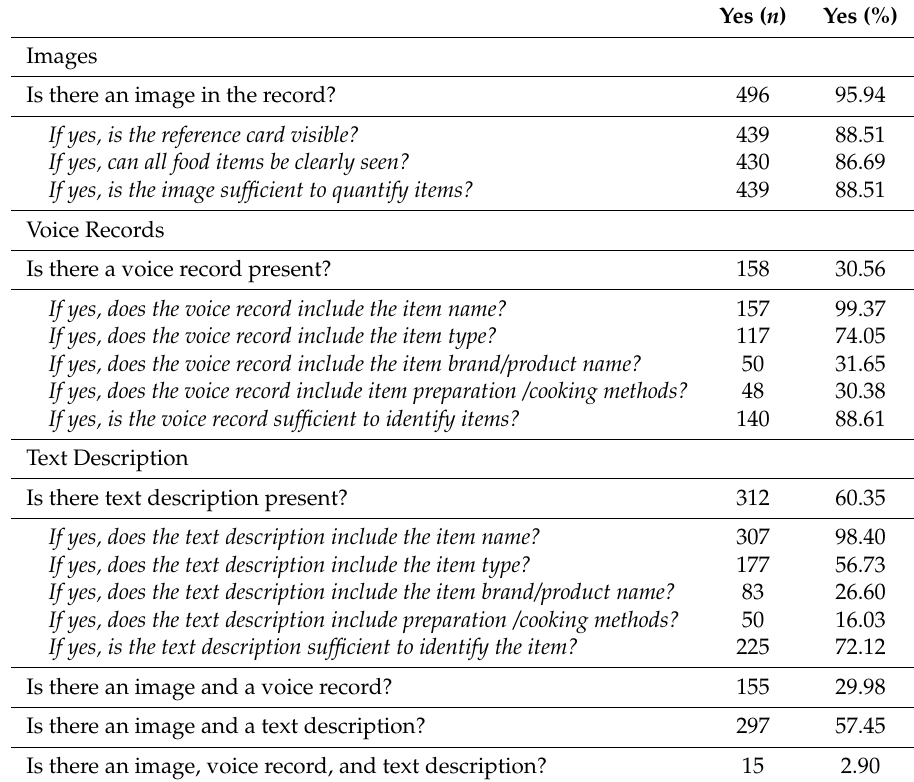
Table 4. Quality assessment of the DietBytes image-based dietary record entries ( n = 517 entries for n = 25